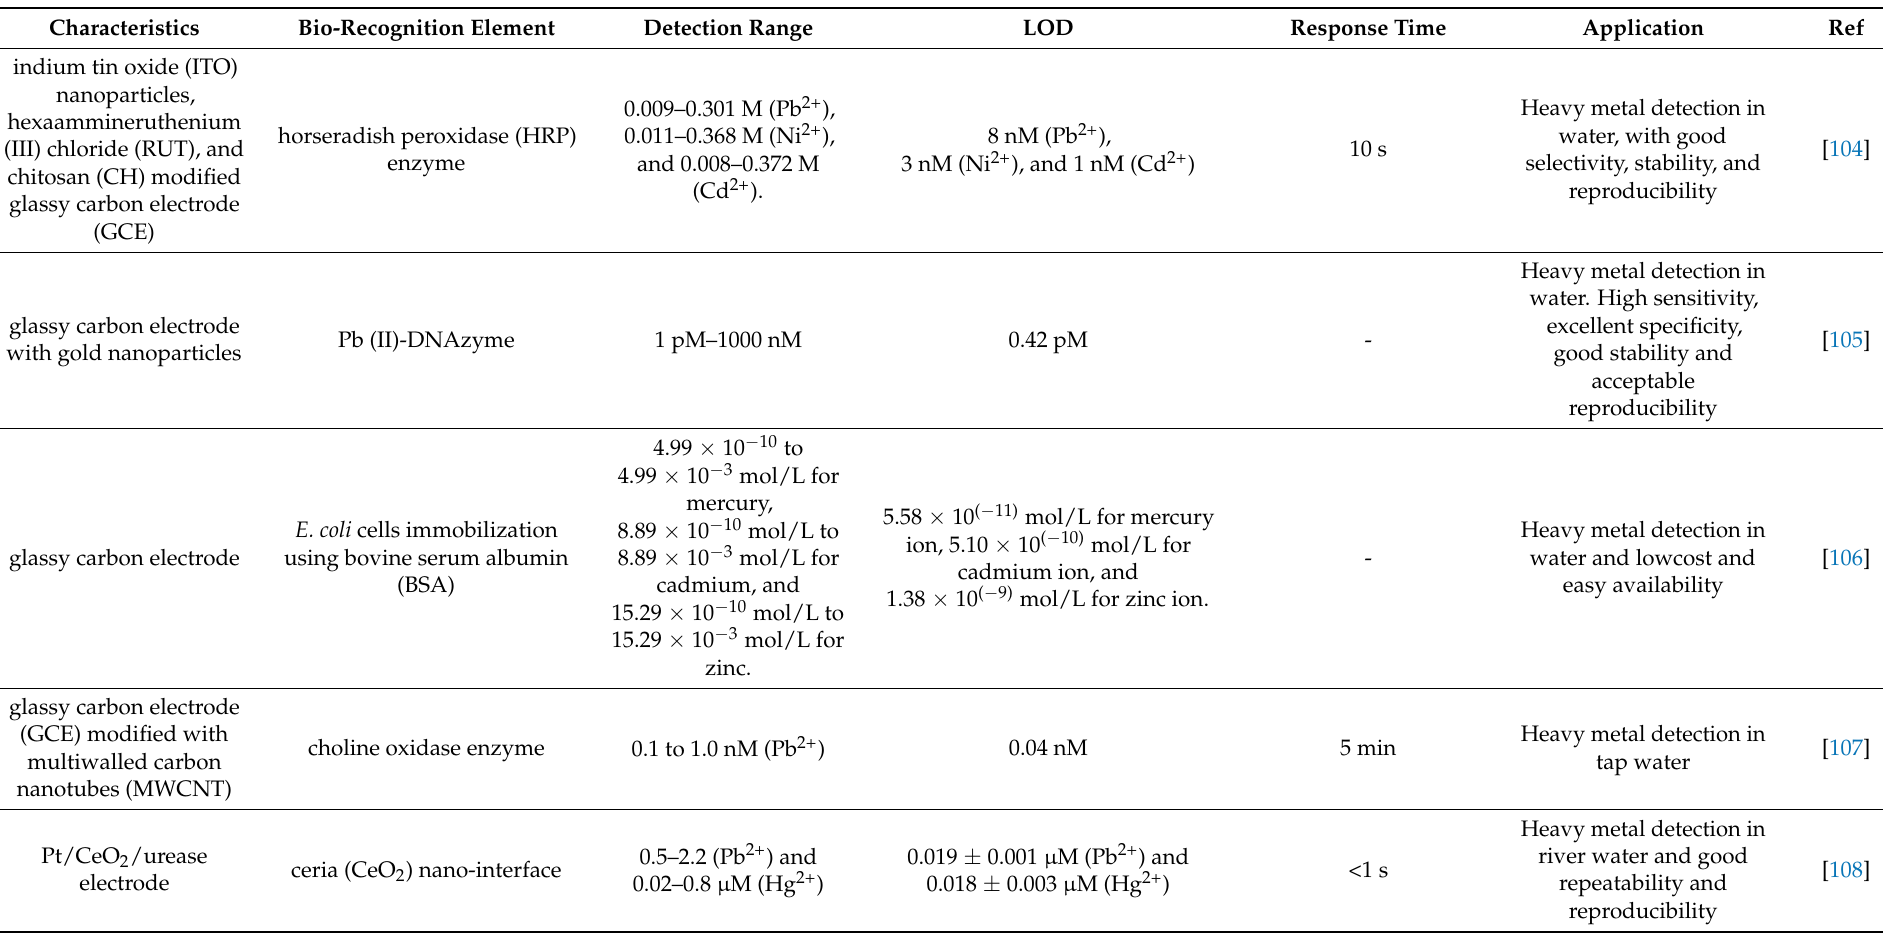
Table 3. Various types of transducers and